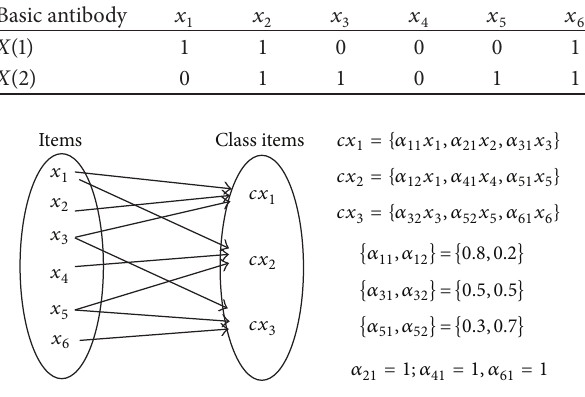
Figure 2: An example of mapping relationship with 6 items and 3 class